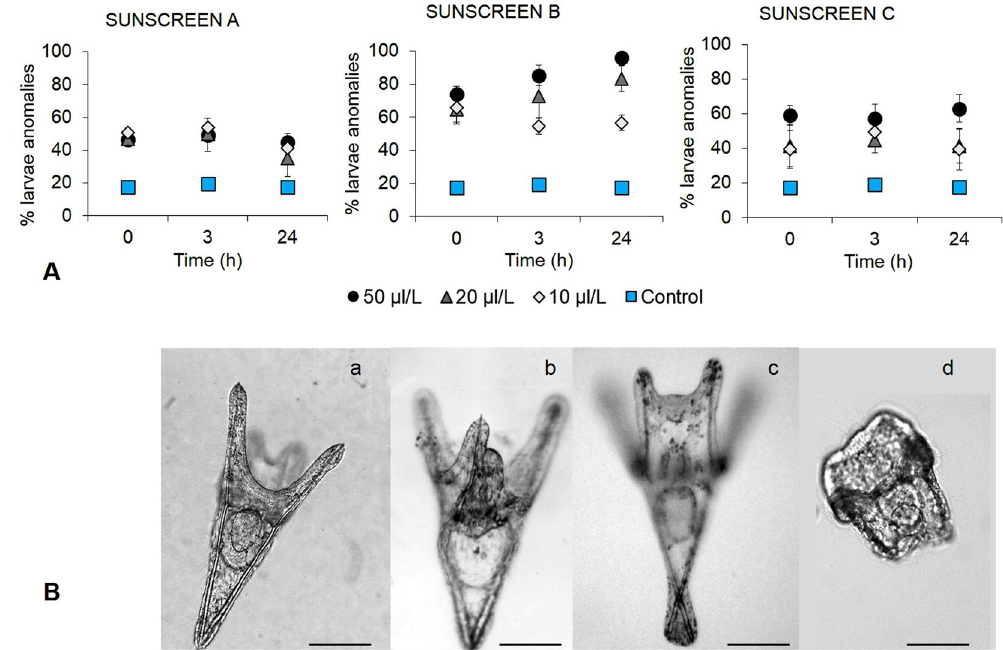
Figure 4. Effect of the sunscreens on the development of larvae of P. lividus . ( A ) Percentages of P. lividus anomalous larvae after exposure to Sunscreens ( A , B and C ), at different concentration (10, 20 and 50 µ L L − 1 ) over time. Error bars represent standard deviation (n = 3). ( B ) Unexposed larva, control (a). Main anomalies found in P. lividus larvae after different exposure times: joined anterior arms (b), crossed skeletal tips at the hood apex (c), incomplete skeletal roots (d). Scale bar: 100 μ